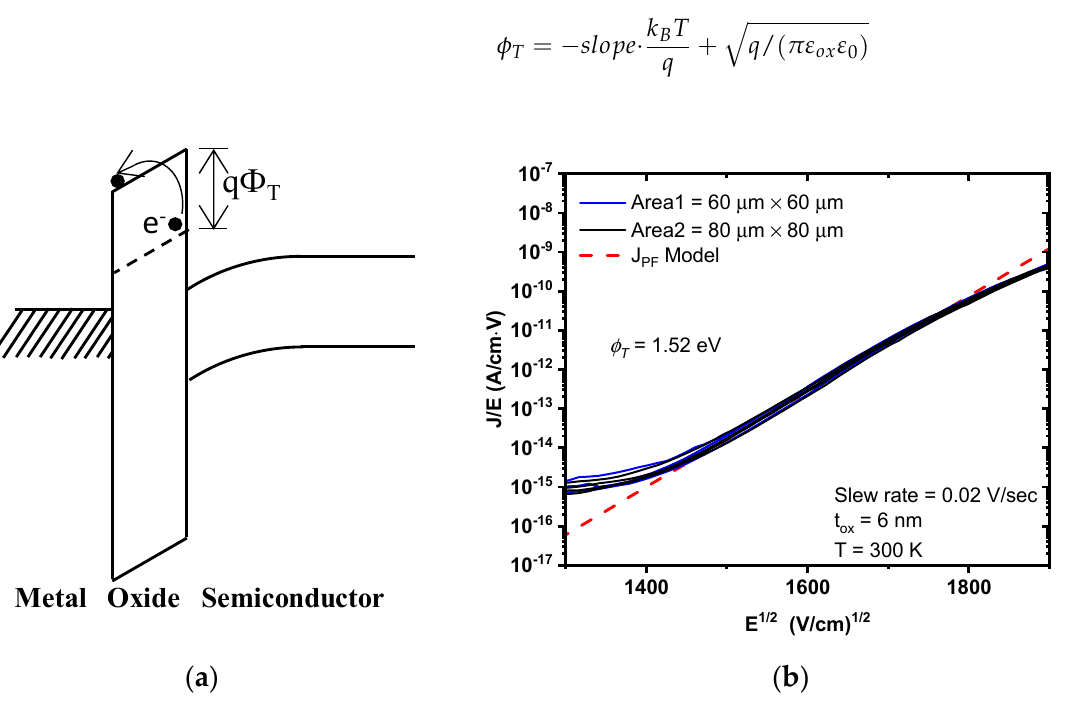
Figure 4. ( a ). Band energy diagram for Poole–Frenkel Emission, and ( b ) comparison of curves Ln(J/E) vs E 1/2 from measured data and Poole–Frenkel Emission model.